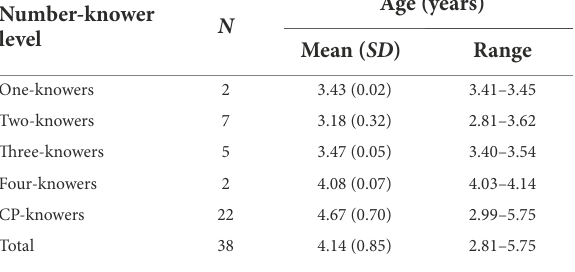
TABLE 2 Ages of children by number-knower level in the give-a- number task.